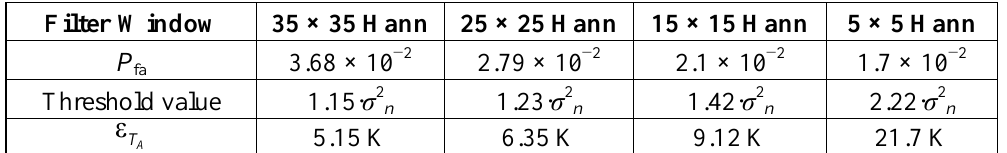
Table 3. Retrieved T error for the best threshold P for the four different cases of A fa Smoothing Algorithm filtering, shown in Figure 14 with a INR value of −5 dB (equivalent to 126.5 K of interference); for the PRN interfering signal case.